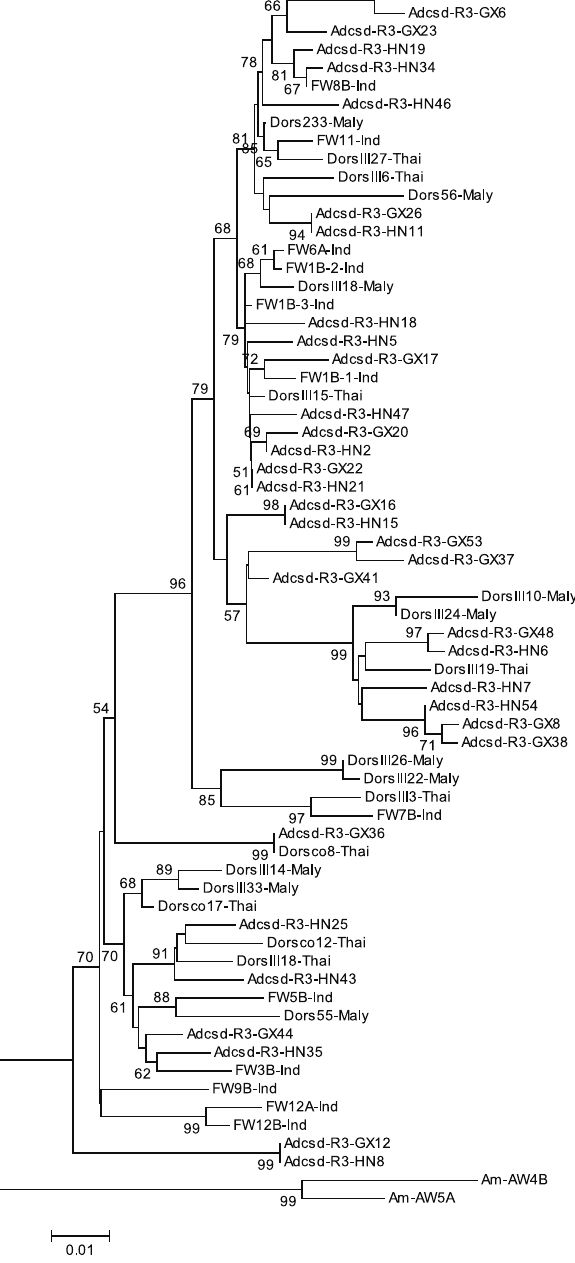
Figure 4. The gene genealogy of region 3 of the A.dorsatacsd alleles from this study and those from Cho et al. 2006 [ 8 ] and Hasselmann et al. 2008 [ 9 ] . The coding sequences of all the alleles were used. The minimum evolution method and Kimura’s two parameter distances were used to construct the tree. Bootstrap percentages are shown on internal branches. The scale bar represents the number of nucleotide changes per site. Amcsd-AW4B and Amcsd- AW5A, both from the Western honey bee Apis mellifera , were used as outgroup sequences.